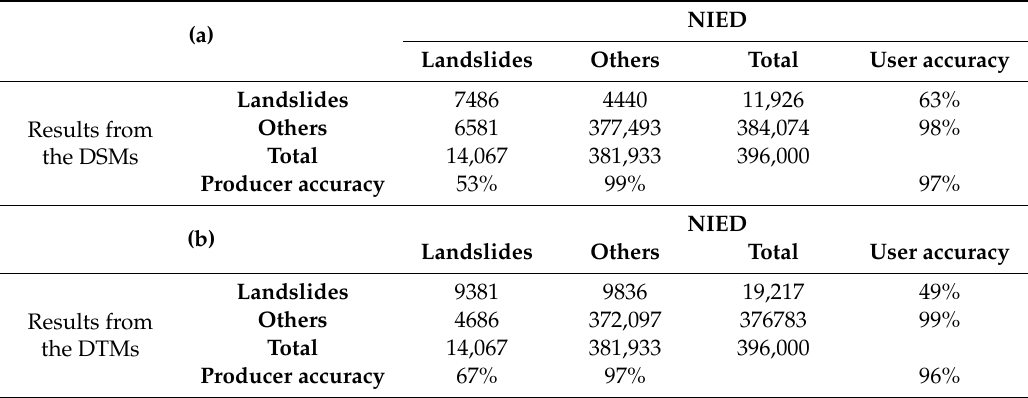
Table 4. Comparison of the detected results with the landslides identified by NIED (m 2